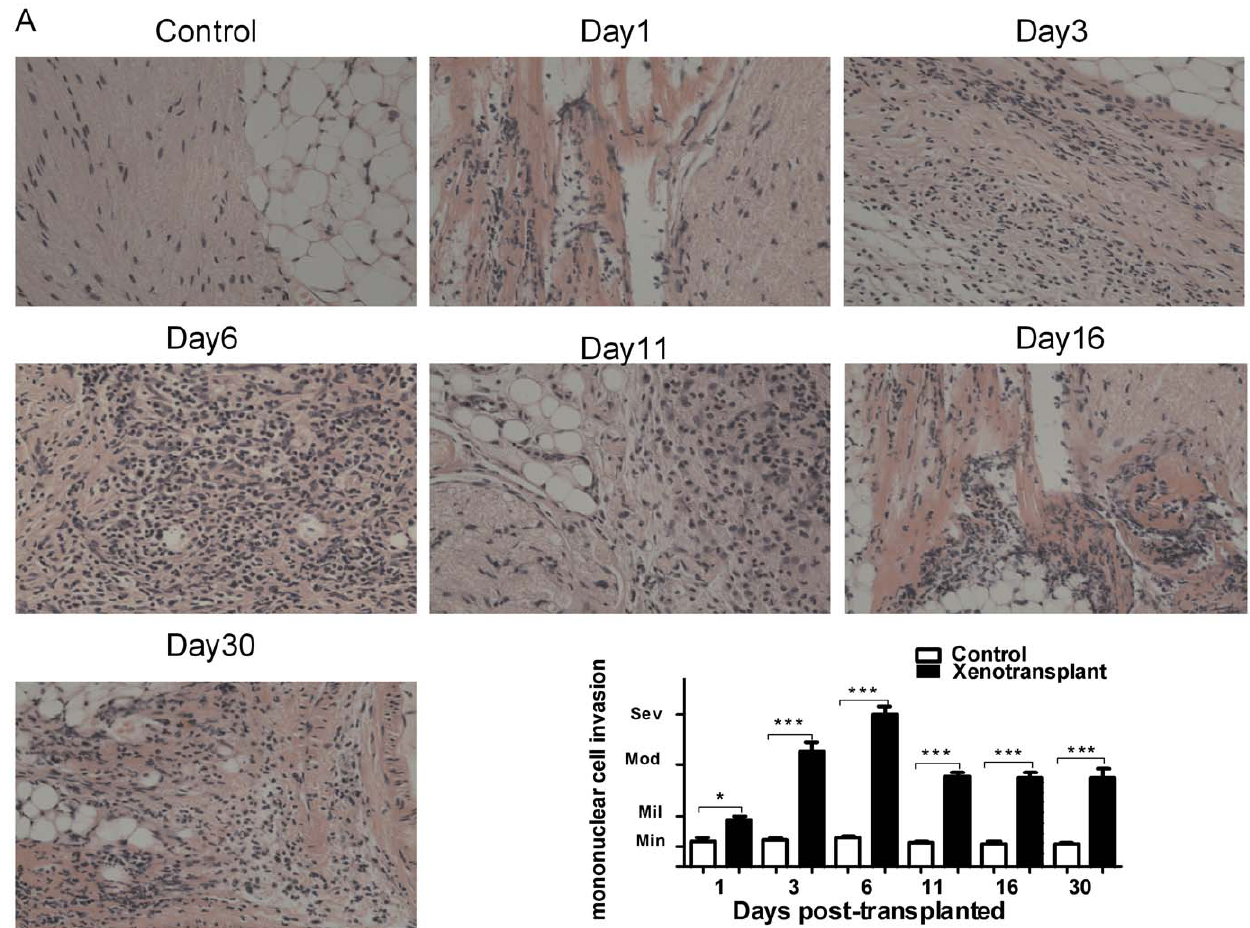
Figure 1. H&E staining of nerve grafts. Sham control or xenotransplanted sciatic nerve from mice was collected at 1, 3, 6, 11, 16, and 30 days posttransplantation, sectioned, and stained with H&E. Staining demonstrated xenograft adhesion to the surrounding tissue, and infiltration of mononuclear cells into the peripheral nerve and surrounding tissue. There was no significant difference during 30 days after xenotransplantation in control group. The level of mononuclear cell infiltration, distension, and necrosis significantly increased in all xenografts at all time point after transplantation compared with control group. Magnification: 200 6 . (We performed animal experiment twice, and stained 2 sections for each animal.)